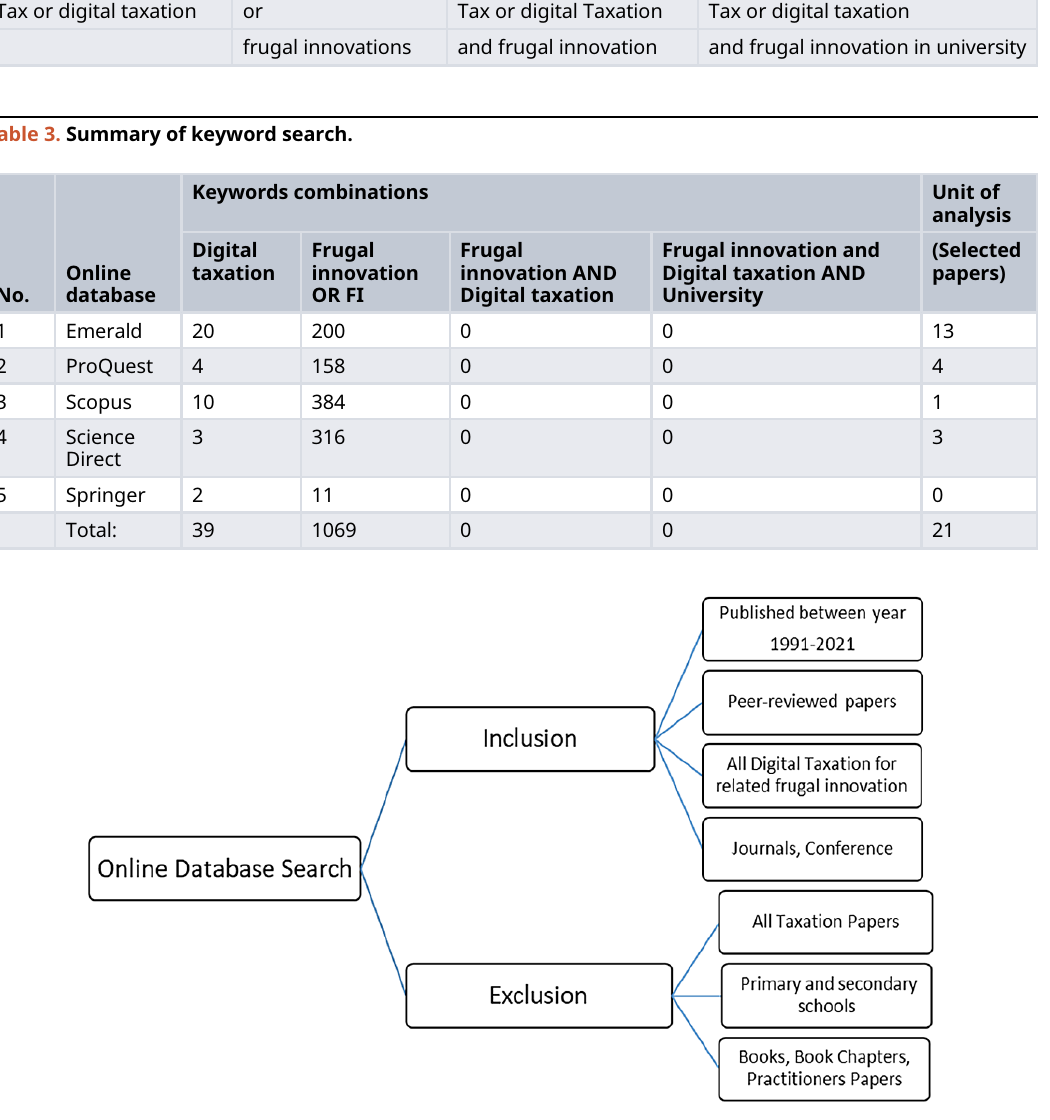
Figure 1. Inclusion and exclusion criteria.